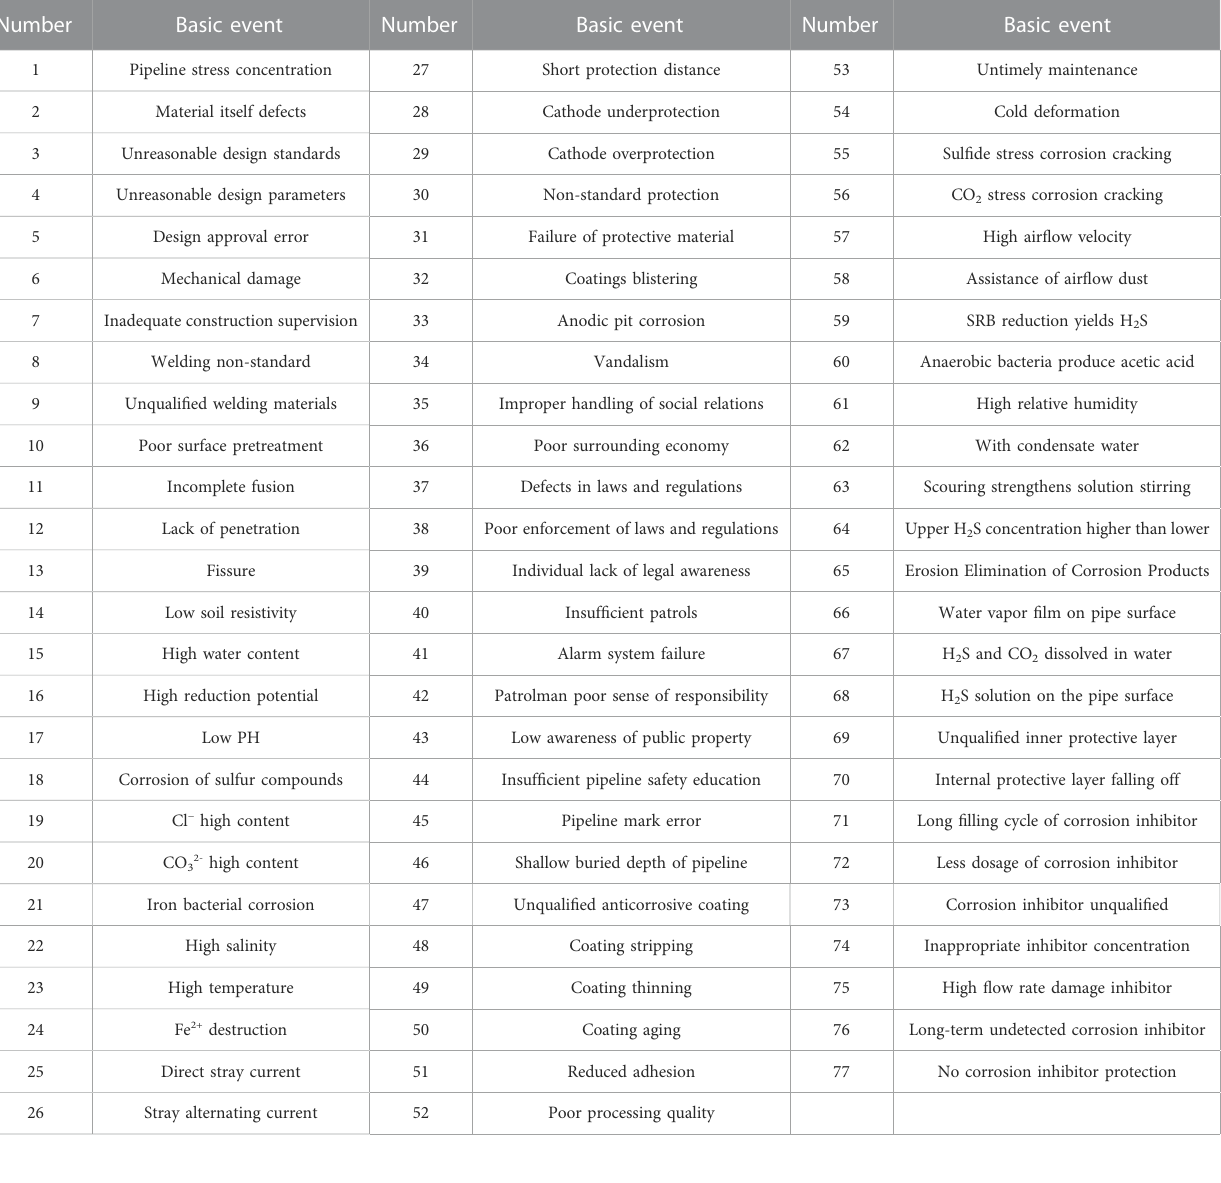
TABLE 1 Basic event list of corrosion failure fault tree of buried oil and gas pipeline.